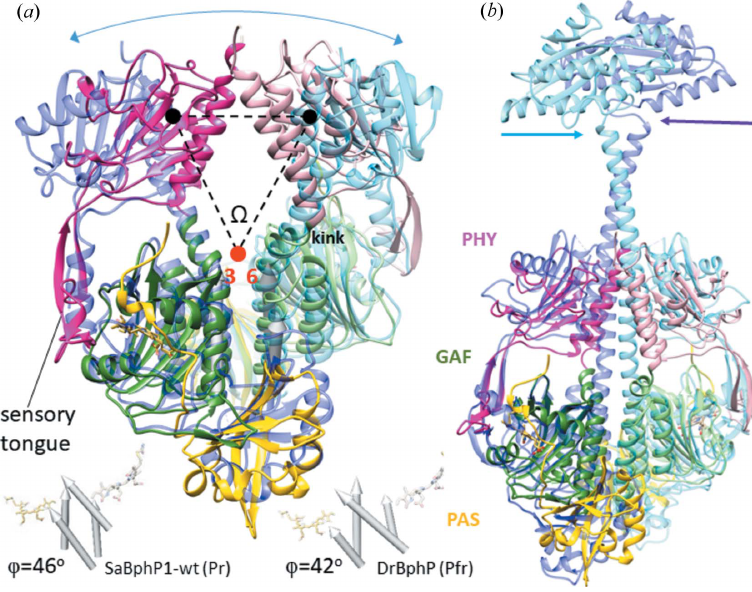
Figure 8 Structural comparison with important BphPs. ( a ) Superposition of the SaBphP1-PCM (Pr) (yellow, green, magenta) onto the DrBphP-PCM (Pfr) in blue (Takala et al. , 2014). The PHY domains are displaced substantially in the Pfr structure (blue curved arrow). The sensory tongue is marked. The four helices at the dimer interface are marked as gray cylinders. The four cylinders are displayed again below the structures (see also Fig. 5). The offset angle ’ between the subunits was measured as described in Appendix B 3. The approximate positions of the SaBphP-PCM’s PHY domain centroids are shown by black spheres. The opening angle (cid:3) is defined by the centroids and a point between the ends of helices three and six (see also Fig. 5 a ). ( b ) Superposition of the SaBphP1-PCM (yellow, green, magenta) on the full length BphP with a di-guanylyl cyclase effector domain from Idiomarina sp. (blue) (Gourinchas et al. , 2017).